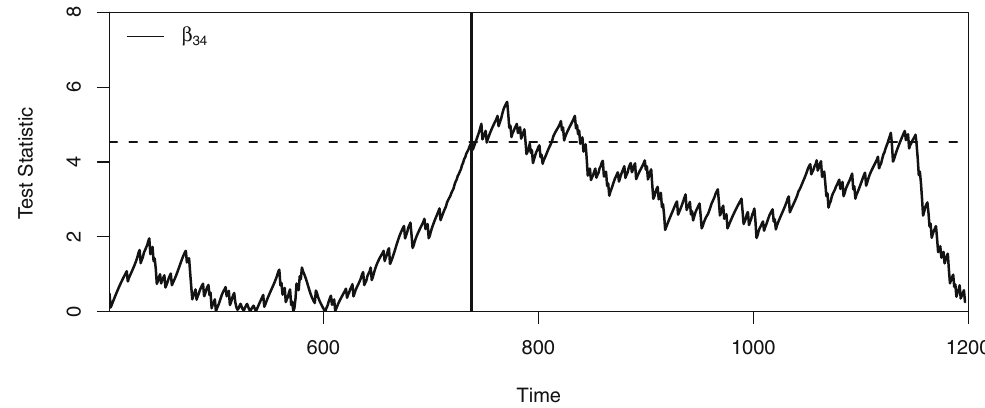
Figure 1: Regression coe ffi cient β